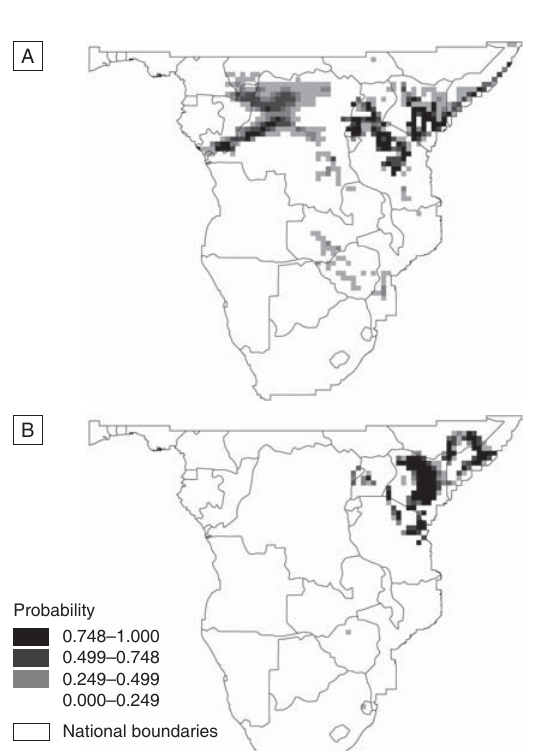
FIG. 10 R. appendiculatus FIG. 11 R. aquatilis